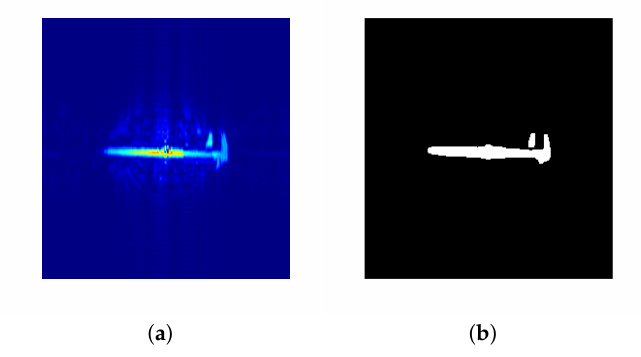
Figure 31. Caliper: ( a ) Scan; ( b ) Segmented